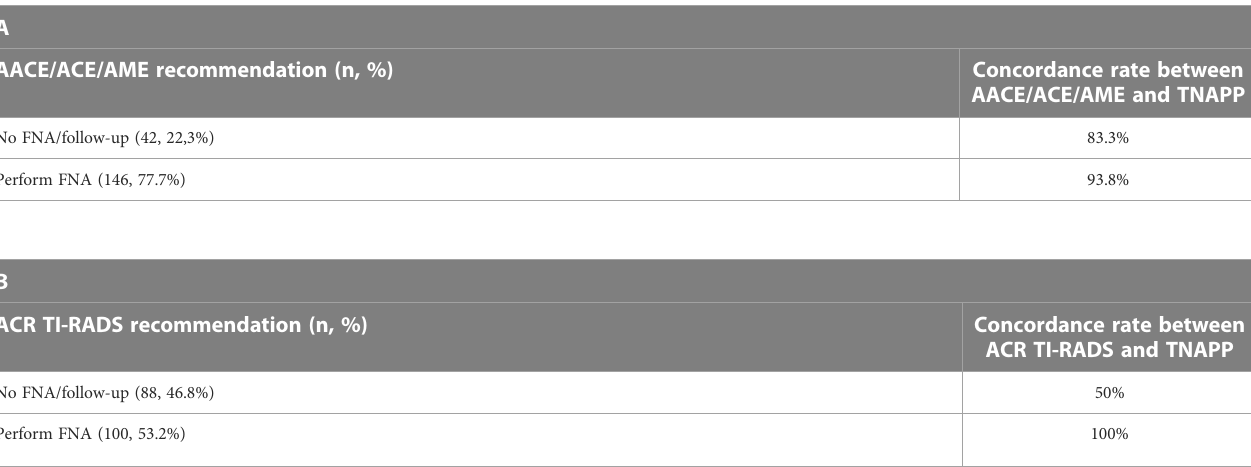
AACE/ACE/AME and TNAPP